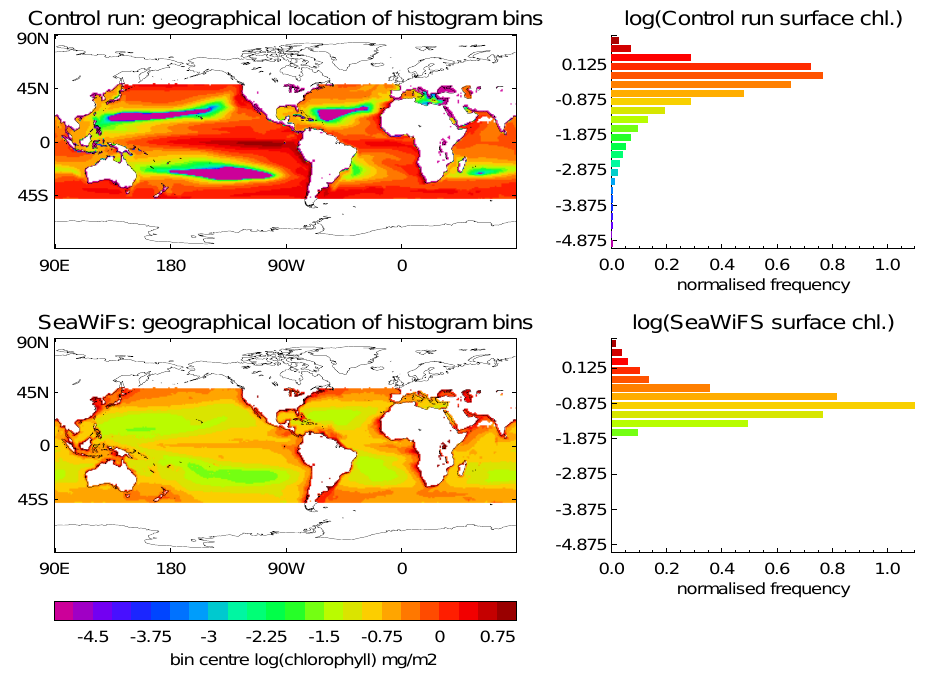
Fig. 20. Comparison of model-generated chlorophyll surface concentrations (top) with observations from SeaWiFs (bottom). The left hand side shows maps whereas the right hand side shows histograms of the statistics on each grid square. The quantity plotted is the log of the concentration in each case.